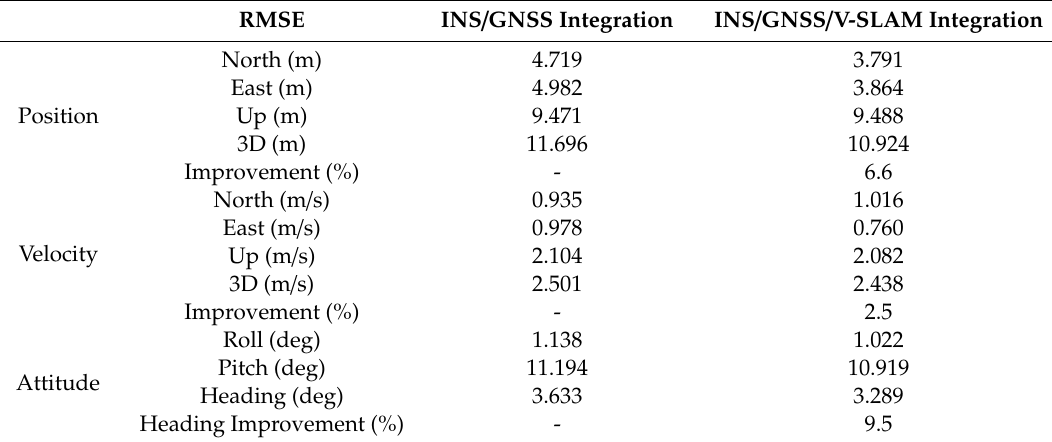
Figure 12. Graphical comparison of the navigation errors associated with the various solutions in the first test. Table 3. Statistical summary of navigation errors in the first test.